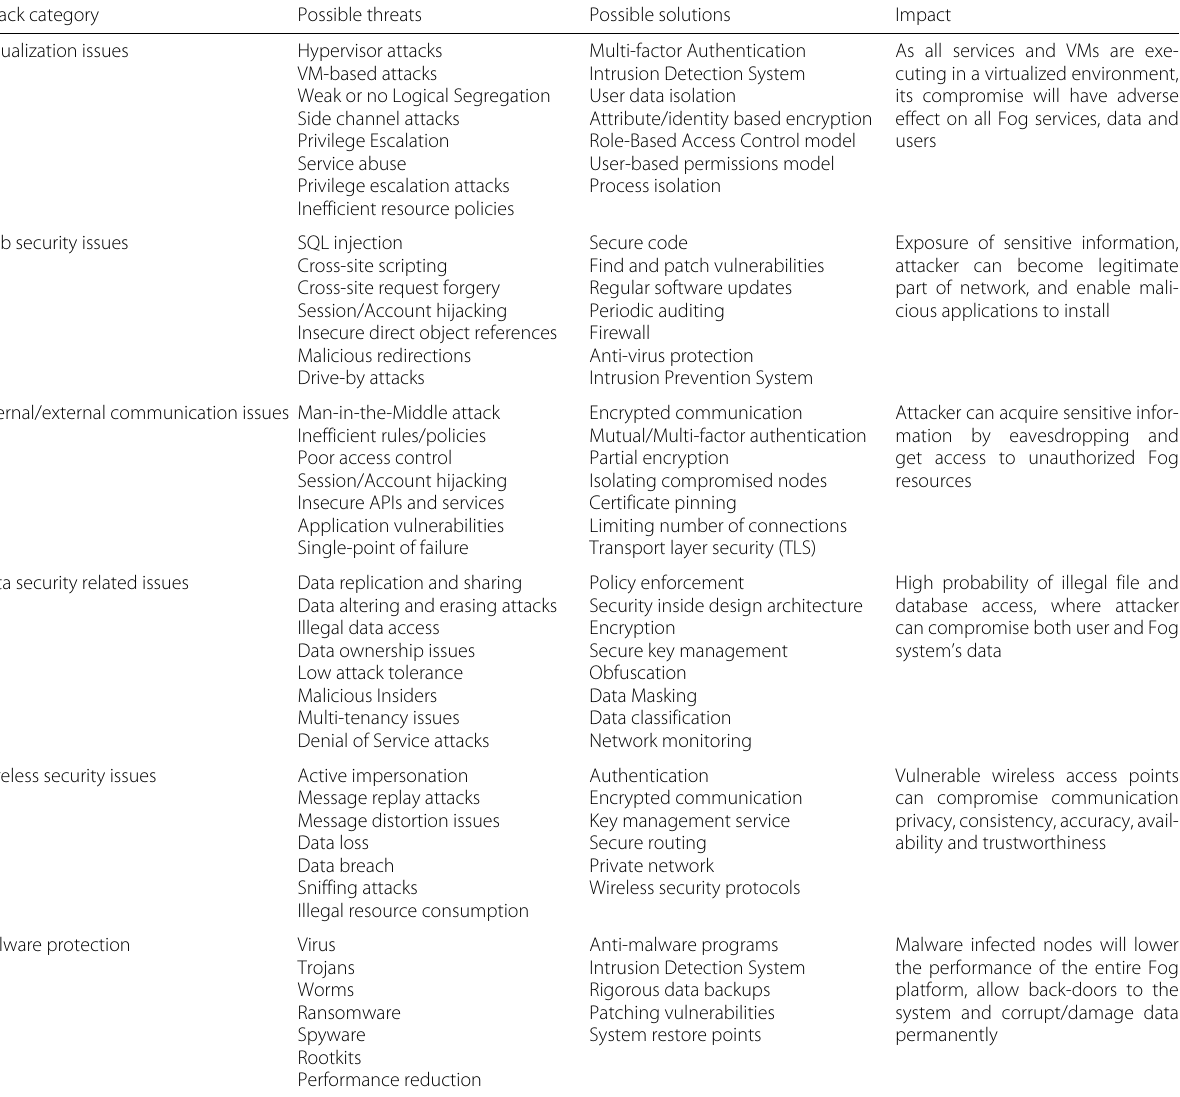
Table 2 Summary of potential security issues found in Fog